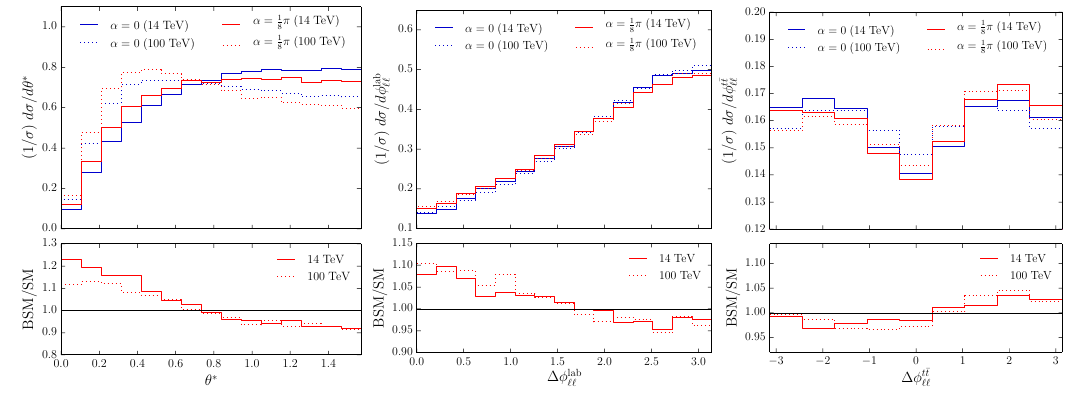
Figure 8 . Comparisons between 14 TeV and 100 TeV distributions of θ ∗ (left), ∆ φ lab ∆ φ t ¯ t (right) after resolving the combinatorial problems described in table 1 and table 2, respectively. ‘‘